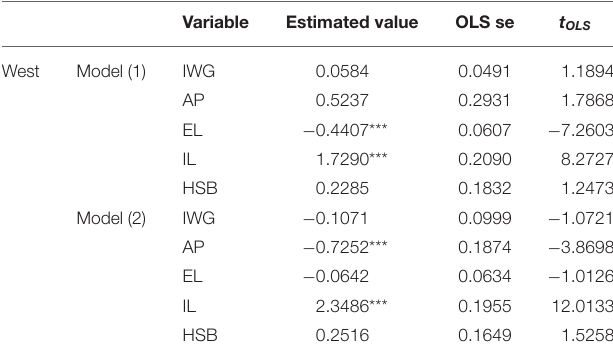
TABLE 4 | Results of the relationship between the two indexes in western